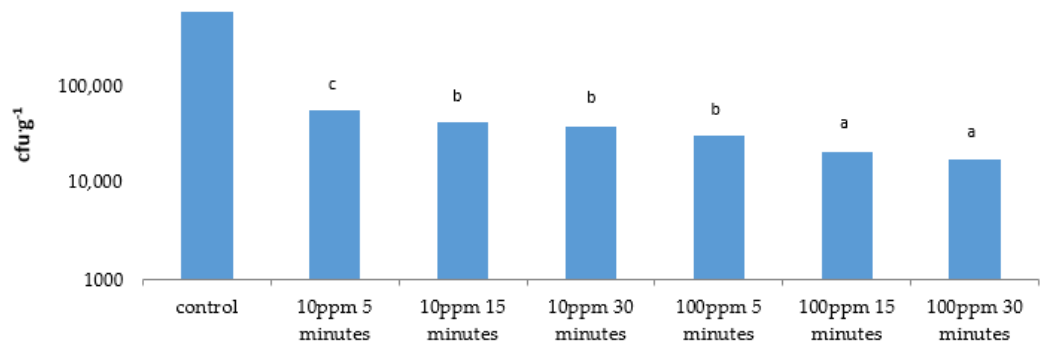
Figure 10. Number of mesophilic lactic acid bacteria in 1 g in rhubarb petioles. The significance of differences in cfu g -1 of mesophilic lactic acid bacteria is marked with different letters, p <0.05